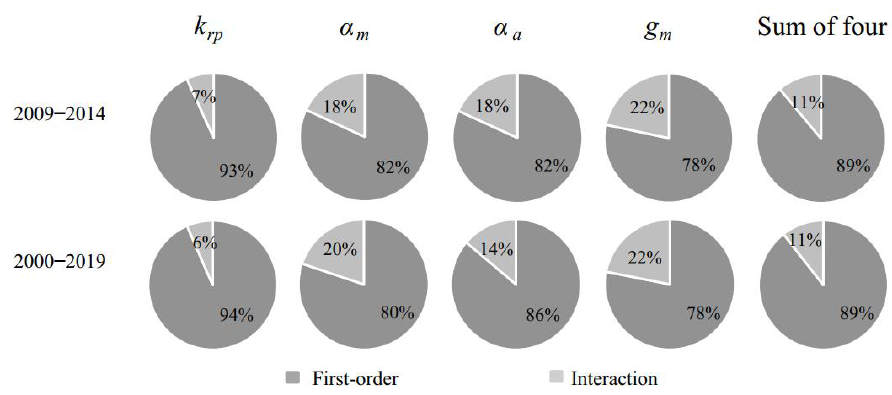
Figure 6. Contribution of the first order and interactions of four parameters based on two methods. Note: The first-order (or interactive) sensitivity index of the sum of four parameters referred to the sum of the first-order (or interactive) sensitivity index of four parameters.